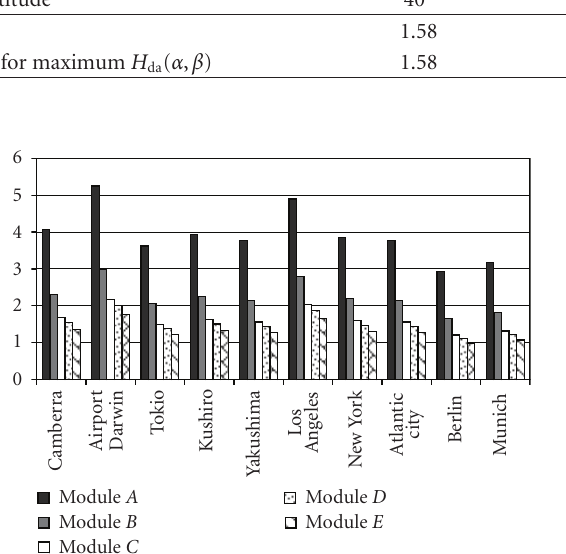
Figure 3: RMS current values ( I RMS ) in Ampere, for di ff erent types of modules located in di ff erent cities.